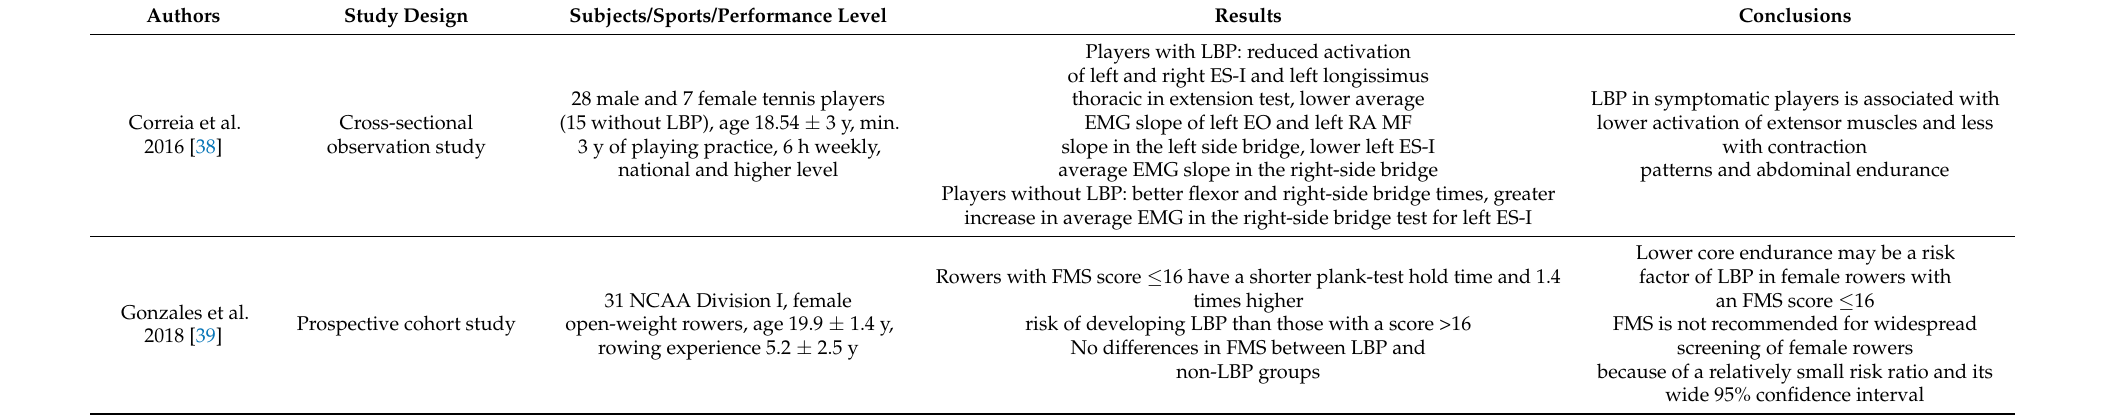
Table 2. Relationships between core characteristics and LBP in individual